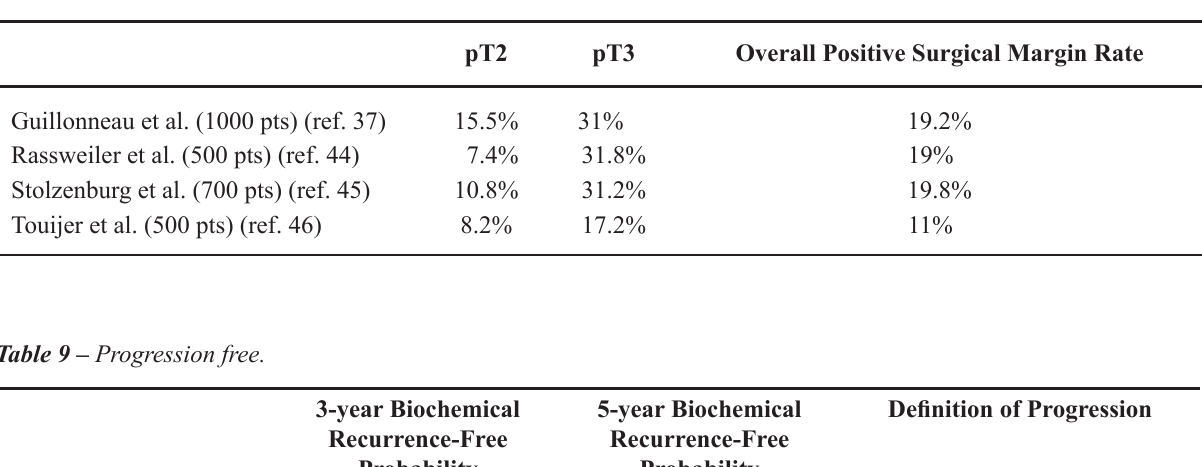
Table 8 – Cancer control: positive surgical margin rate. Guillonneau et al. (1000 pts) (ref. 37)